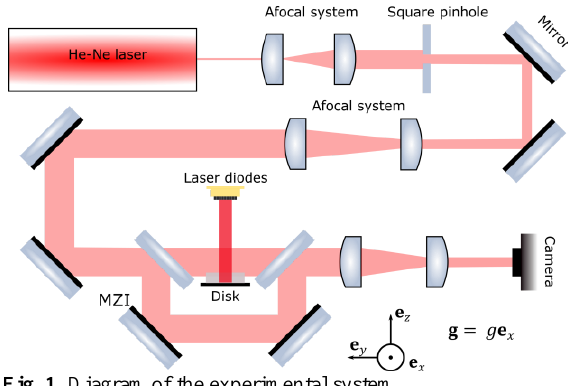
Fig. 1. Diagram of the experimental